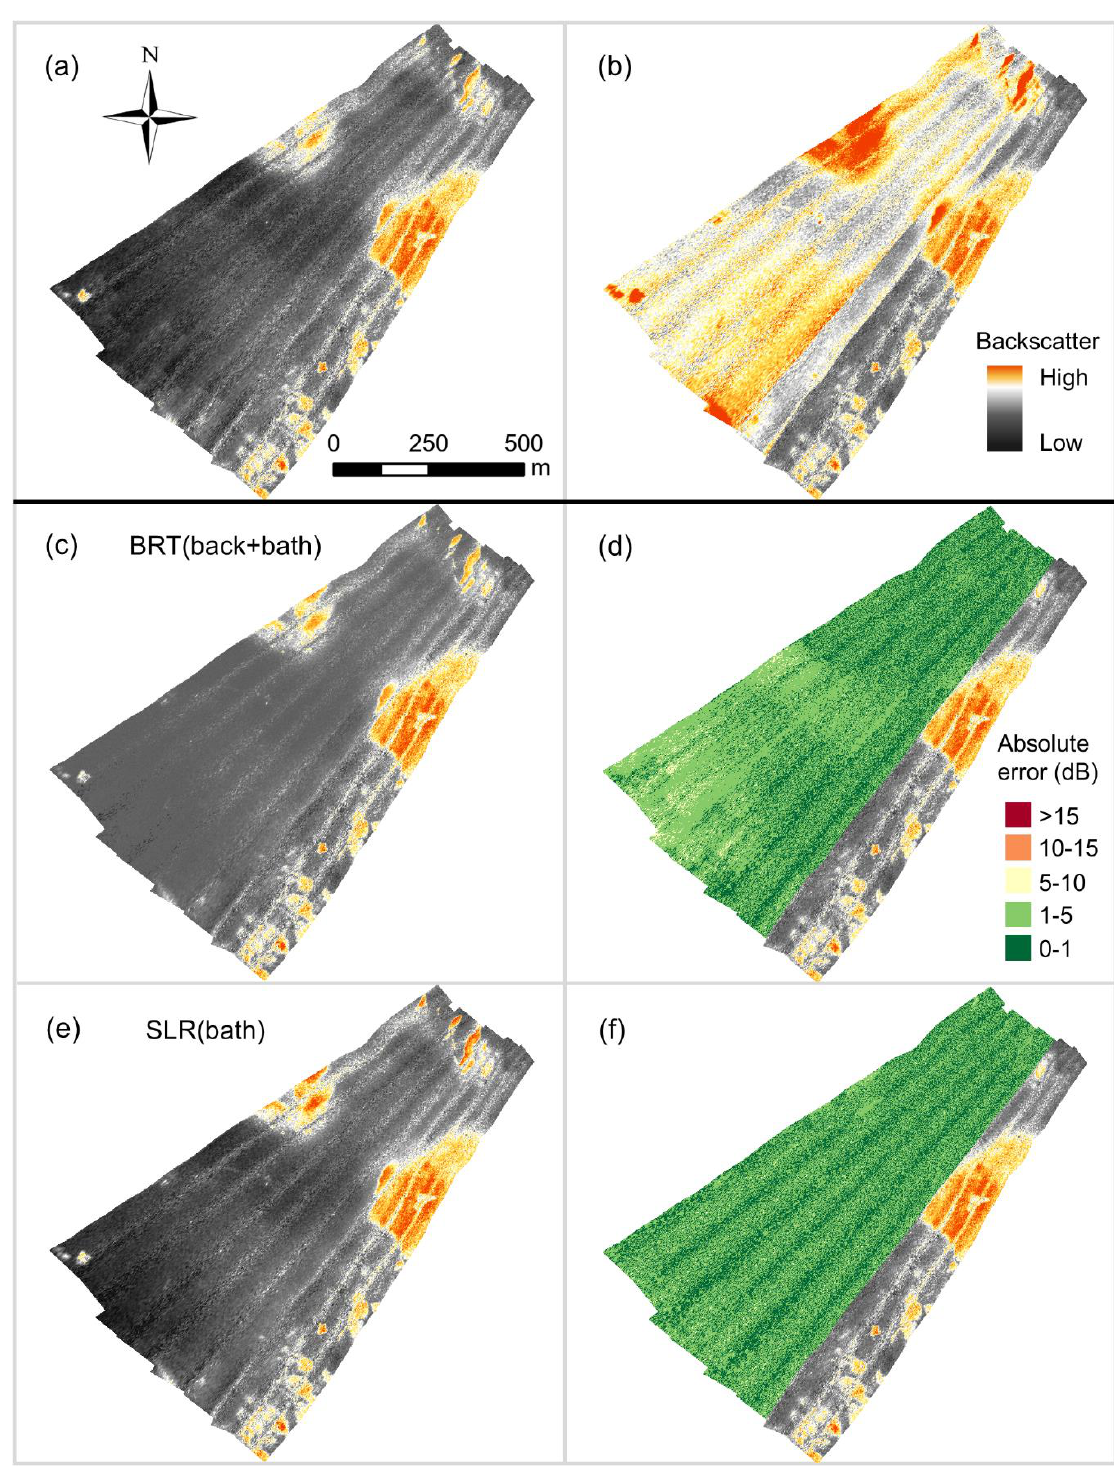
Figure 11. ( a ) Target 400 kHz Patricia Bay backscatter dataset, ( b ) uncorrected mosaic with 200 kHz data, ( c ) BRT(back+bath) mosaic, ( d ) spatial distribution of BRT(back+bath)-shifted backscatter error, ( e ) SLR(bath) mosaic, and ( f ) spatial distribution of SLR(bath)-shifted backscatter error.